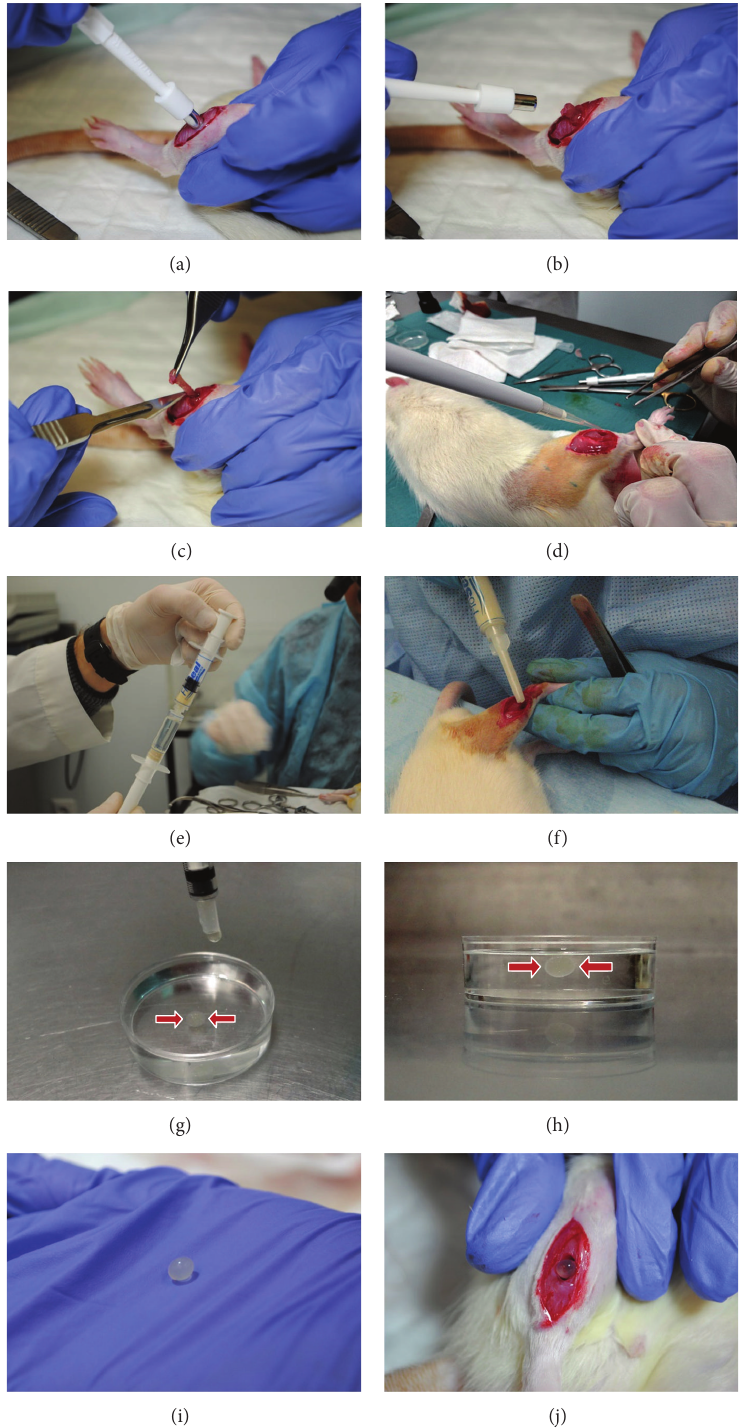
Figure 2: Biopsy punch for myectomy lesion creating a 5 mm Ø defect in the rat’s tibialis anterior (TA) muscle (a–c). In the MSCFibrin group, the defect was filled with a cellular suspension containing 1 × 10 6 HMSCs and 30 𝜇 L of fibrin glue (Tisseellyo) (d). Preparation of Floseal: the gelatin matrix granules syringe is connected to the syringe containing the thrombin solution and the mixture is transferred back and forth between the syringes for a total of 10 passes (e). Application of Floseal in a 5mm Ø myectomy defect (f). Preparation of the spherical hydrogel: the polymer solution containing alginate and sodium hyaluronate in a ratio of 1: 1(V/V) was inserted into an insulin syringe and a droplet was released into an excess of cerium nitrate solution 135mM in order to obtain a cross-linked polymer sphere of approximately 60 𝜇 L in volume (g–i). Application of the previously prepared spherical hydrogel in a 5 mm Ø myectomy defect